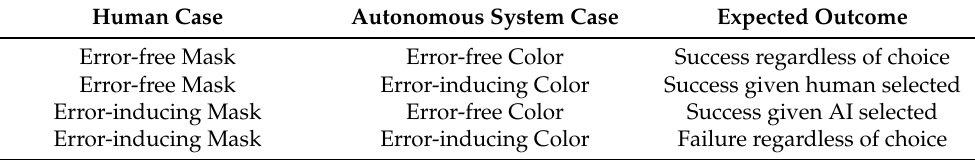
Table 7. Human–AI pair cases.